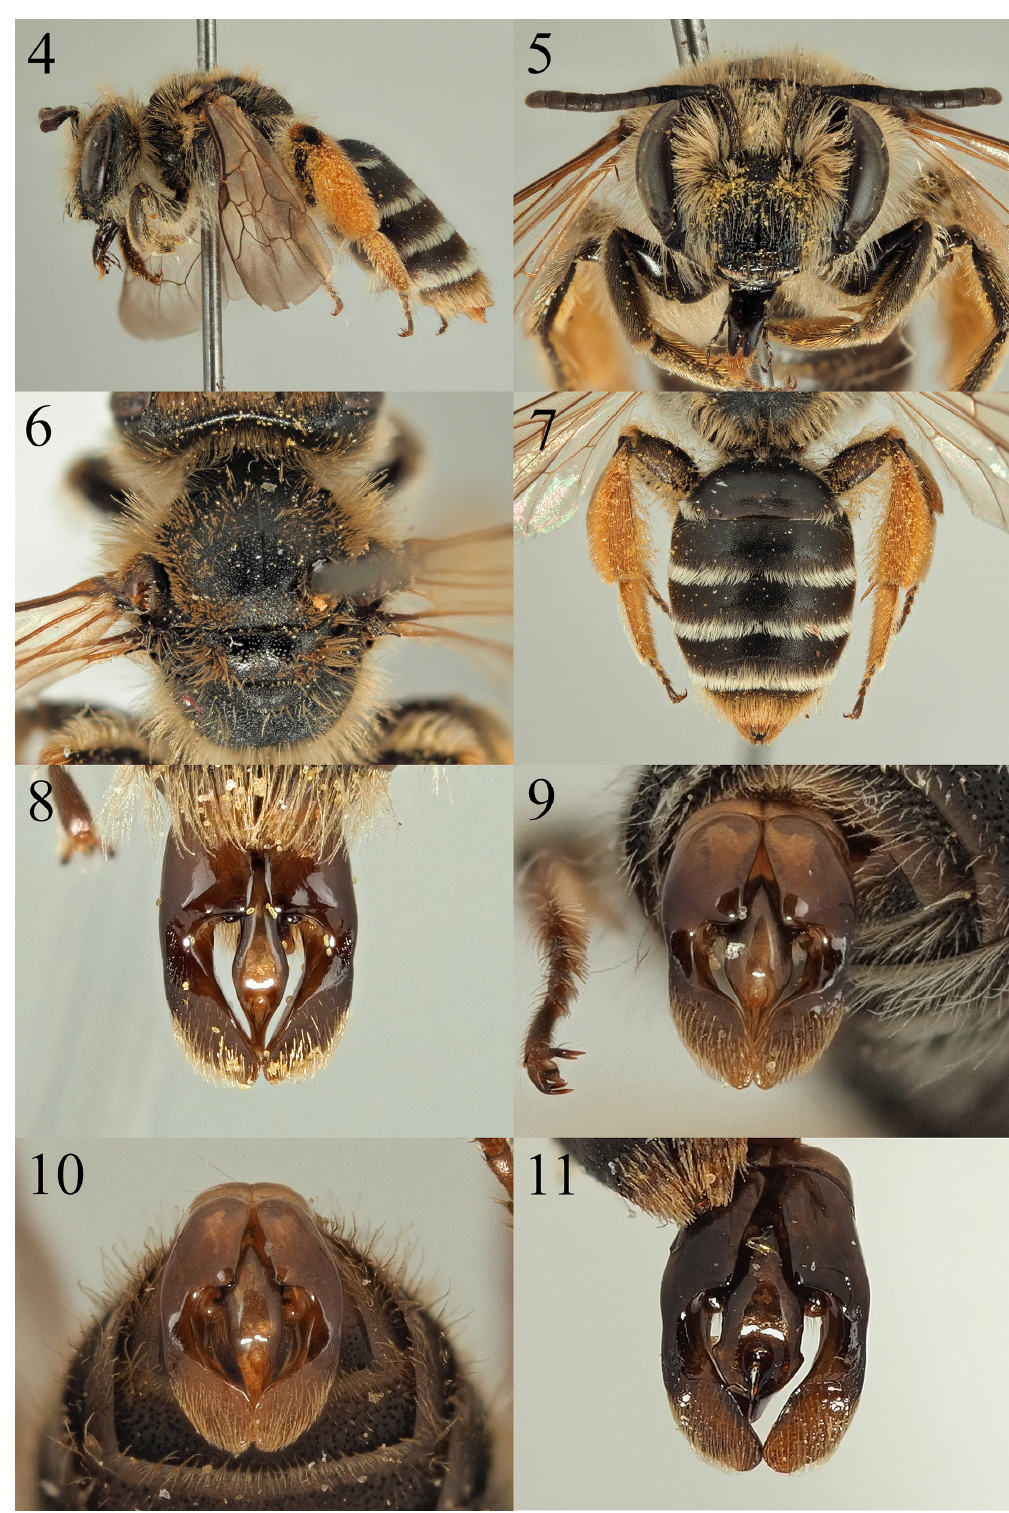
Figs 4–11. 4–8. Andrena gredana Warncke, 1975 stat. nov. (TJWC). 4 . Female profile. 5 . Female face. 6 . Female scutum. 7 . Female terga. 8 . Male genitalia. 9 . Andrena gelriae van der Vecht, 1927, male genitalia. 10 . Andrena levante Wood & Praz sp. nov., male genitalia. 11 . Andrena intermedia